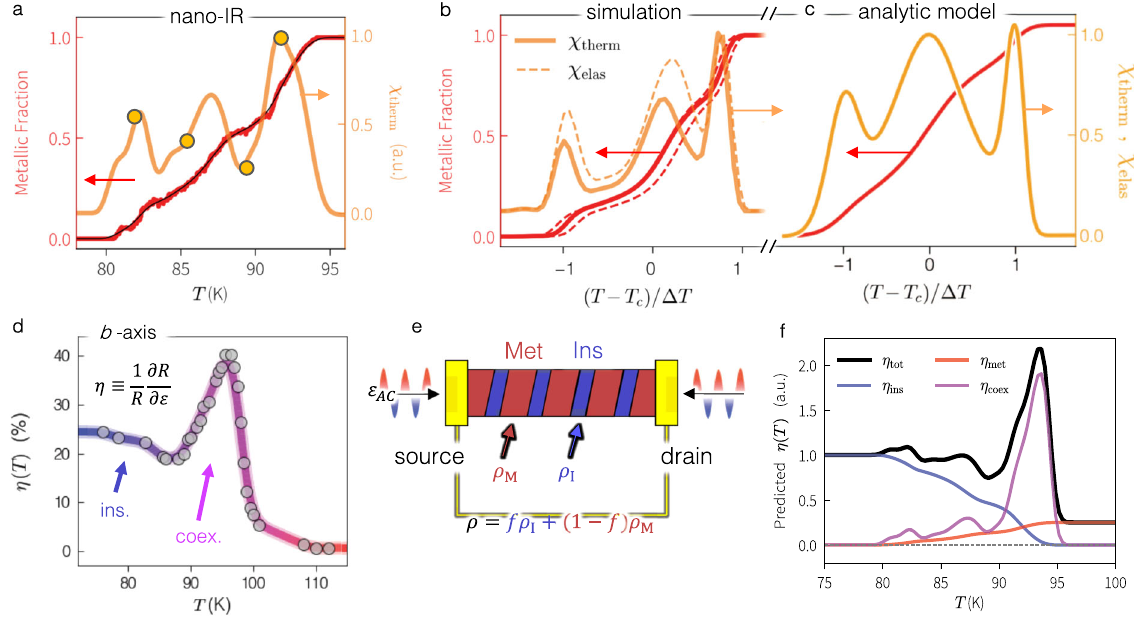
Fig. 4 Signatures of emergent Mott domain susceptibility. a T-dependent metallic fraction f from Fig. 3a together with thermal ¼ d f = d T (orange); circular points quantify the elastic susceptibility χ susceptibility χ therm Fig. 3c – f. b Phase- fi eld simulations and ( c ) a semi-analytic model of domain evolution both predict the characteristic temperature dependence and χ . d An anomalous peak in elastoresistance η emerges in the phase coexistence regime of the thermal transition; gray markers of χ therm elas indicate experimental data whereas the colored curve is a guide to the eye; ins. and coex. respectively indicate insulating and phase- coexistent temperature regimes. e A simple circuit model allows to ( f ) predict η based on the elastic susceptibility inferred from ( a ) for the same insulator-metal mixture observed by nano-IR imaging (see